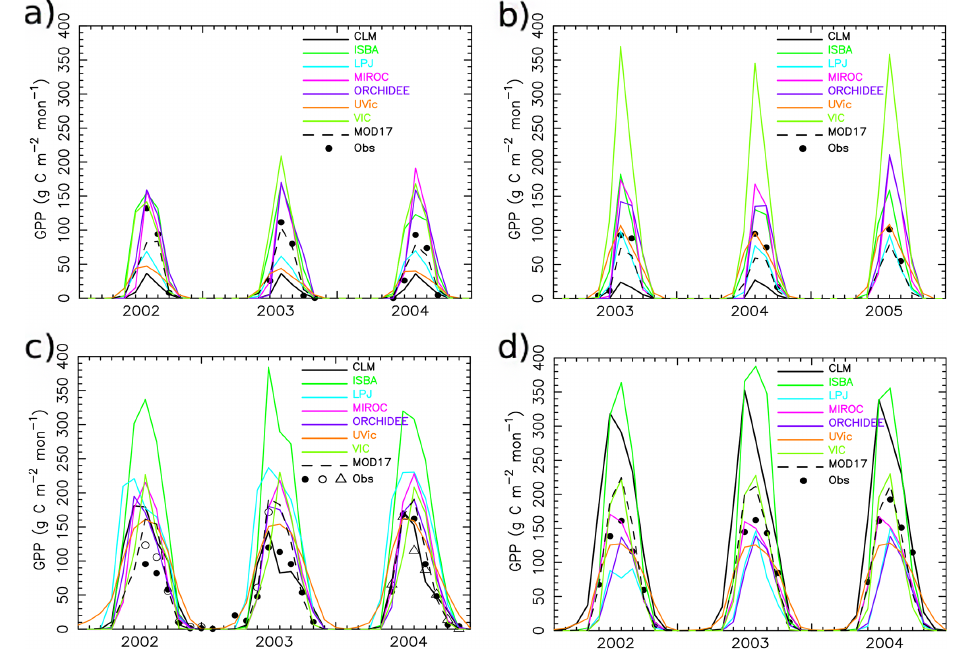
Figure 2. Monthly GPP at sites (a) Chersky, (b) Chokurdakh, (c) Hakasija, and (d) Zotino (Obs, Table 3). Colored lines trace monthly GPP for each model grid that encompasses the tower location. Site Hakasija includes research areas Ha1 (filled circle), Ha2 (open circle), and Ha3